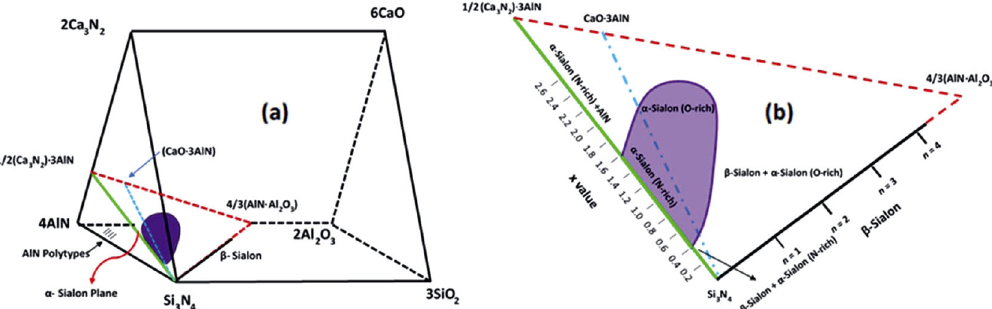
Fig. 1 Regenerated schematic representation of (a) Janecke prism of Ca-sialon system and (b) α-plane in Ca-sialon system at 1800 ℃